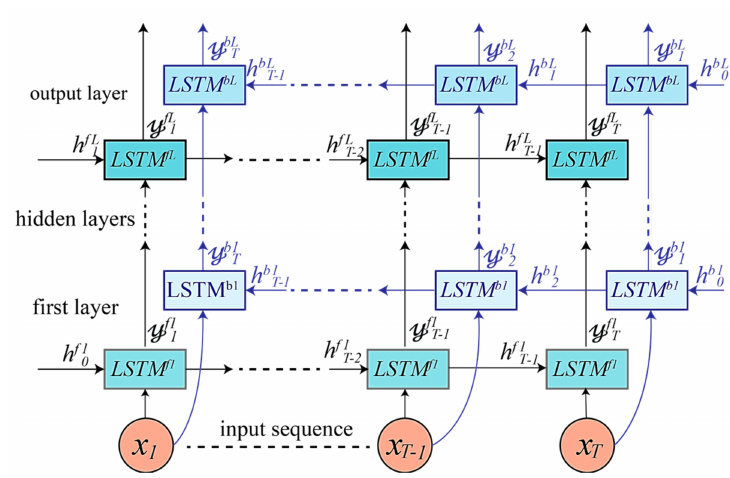
Figure 5. Bidirectional LSTM-based DRNN model consisting of an input layer, multiple hidden layers, and an output layer. Every layer has a forward LSTM f (cid:96) and a backward LSTM b (cid:96) track, and the number of hidden layers is a hyperparameter that is tuned during training.